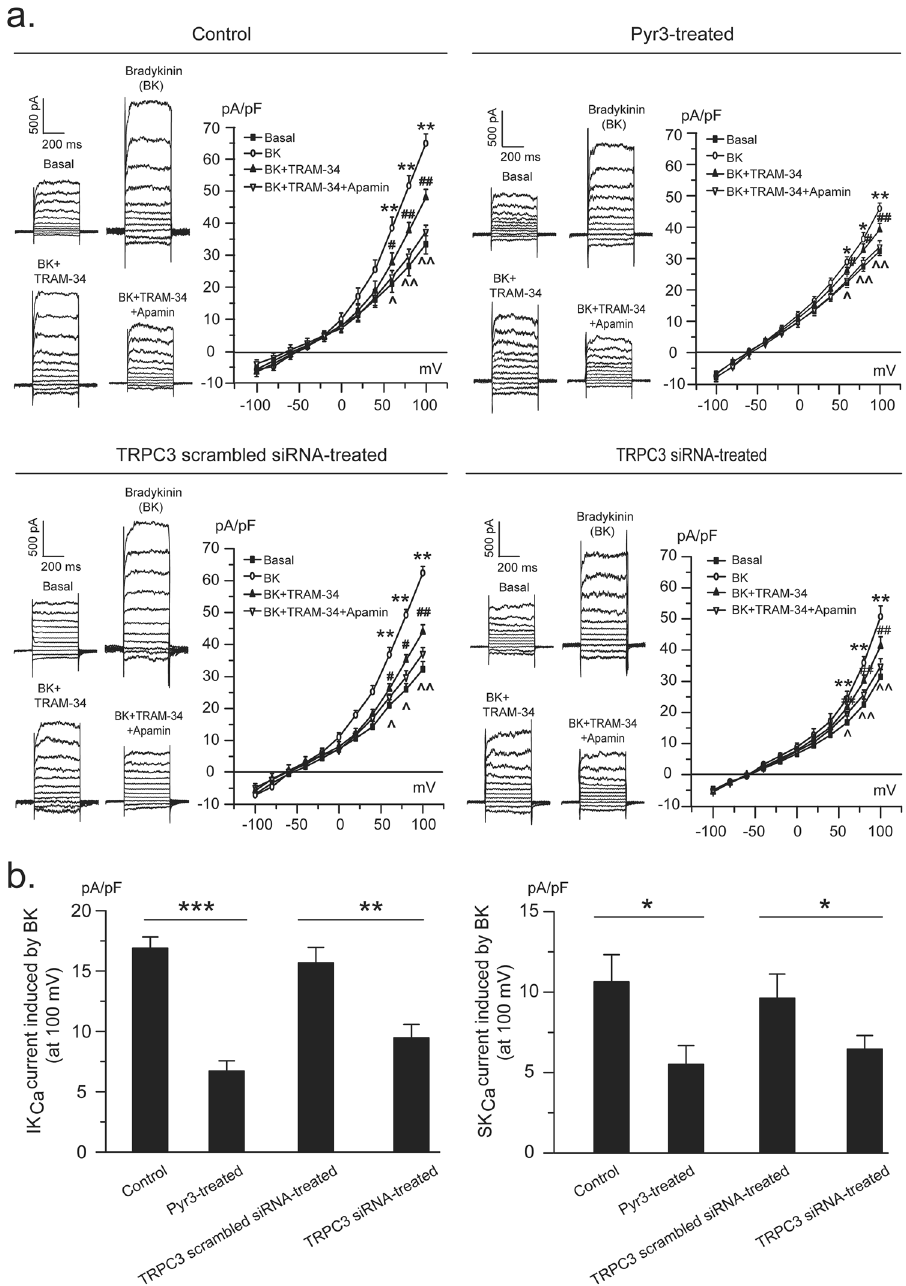
Figure 1. In PCAECs pre-treated with the TRPC3 selective blocker Pyr3 or transfected with TRPC3 specific siRNA, both IK Ca and SK Ca currents in response to bradykinin (BK) were significantly inhibited. ( a ) Representative traces and current-voltage relationship of whole-cell K + current in PCAECs from different treatment groups before and after BK stimulation with further application of the IK Ca channel blocker TRAM- 34 and the SK Ca channel blocker apamin. * p < 0.05, ** p < 0.01, BK vs. basal; # p < 0.05, ## p < 0.01, BK + TRAM- 34 vs. BK; ^ p < 0.05, ^^ p < 0.01, BK + TRAM-34 + Apamin vs. BK + TRAM-34. ( b ) Summarized data of BK- induced IK Ca and SK Ca currents from 5 independent experiments, each obtained from cell isolates of different heart. * p < 0.05, ** p < 0.01, *** p < 0.001, one-way ANOVA and Scheffe post-hoc